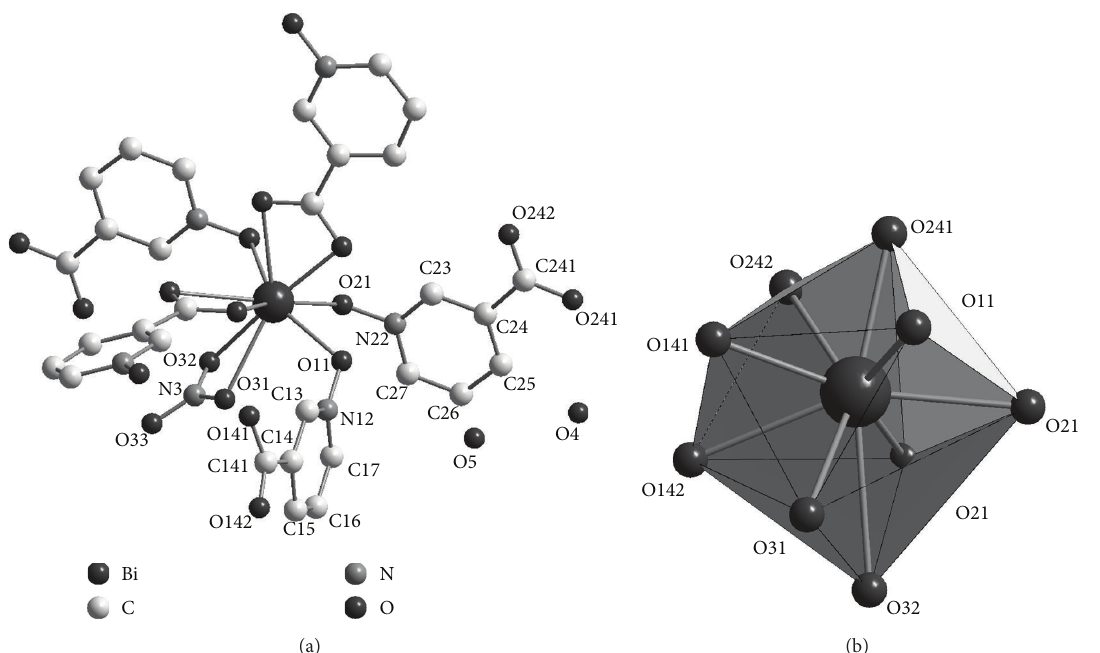
Figure 1: (a) Molecular structure of { [Bi(NNO) 2 (NO 3 )] ⋅ 1.5H 2 O } 𝑛 ( 1 ) and (b) the coordination sphere of the bismuth